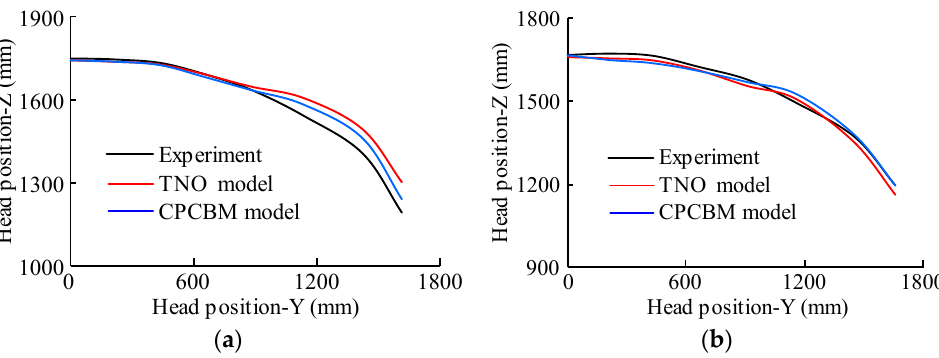
Figure A7. The trajectory of the head COG in the YOZ plane: ( a ) test V2371 and ( b ) test V2374.